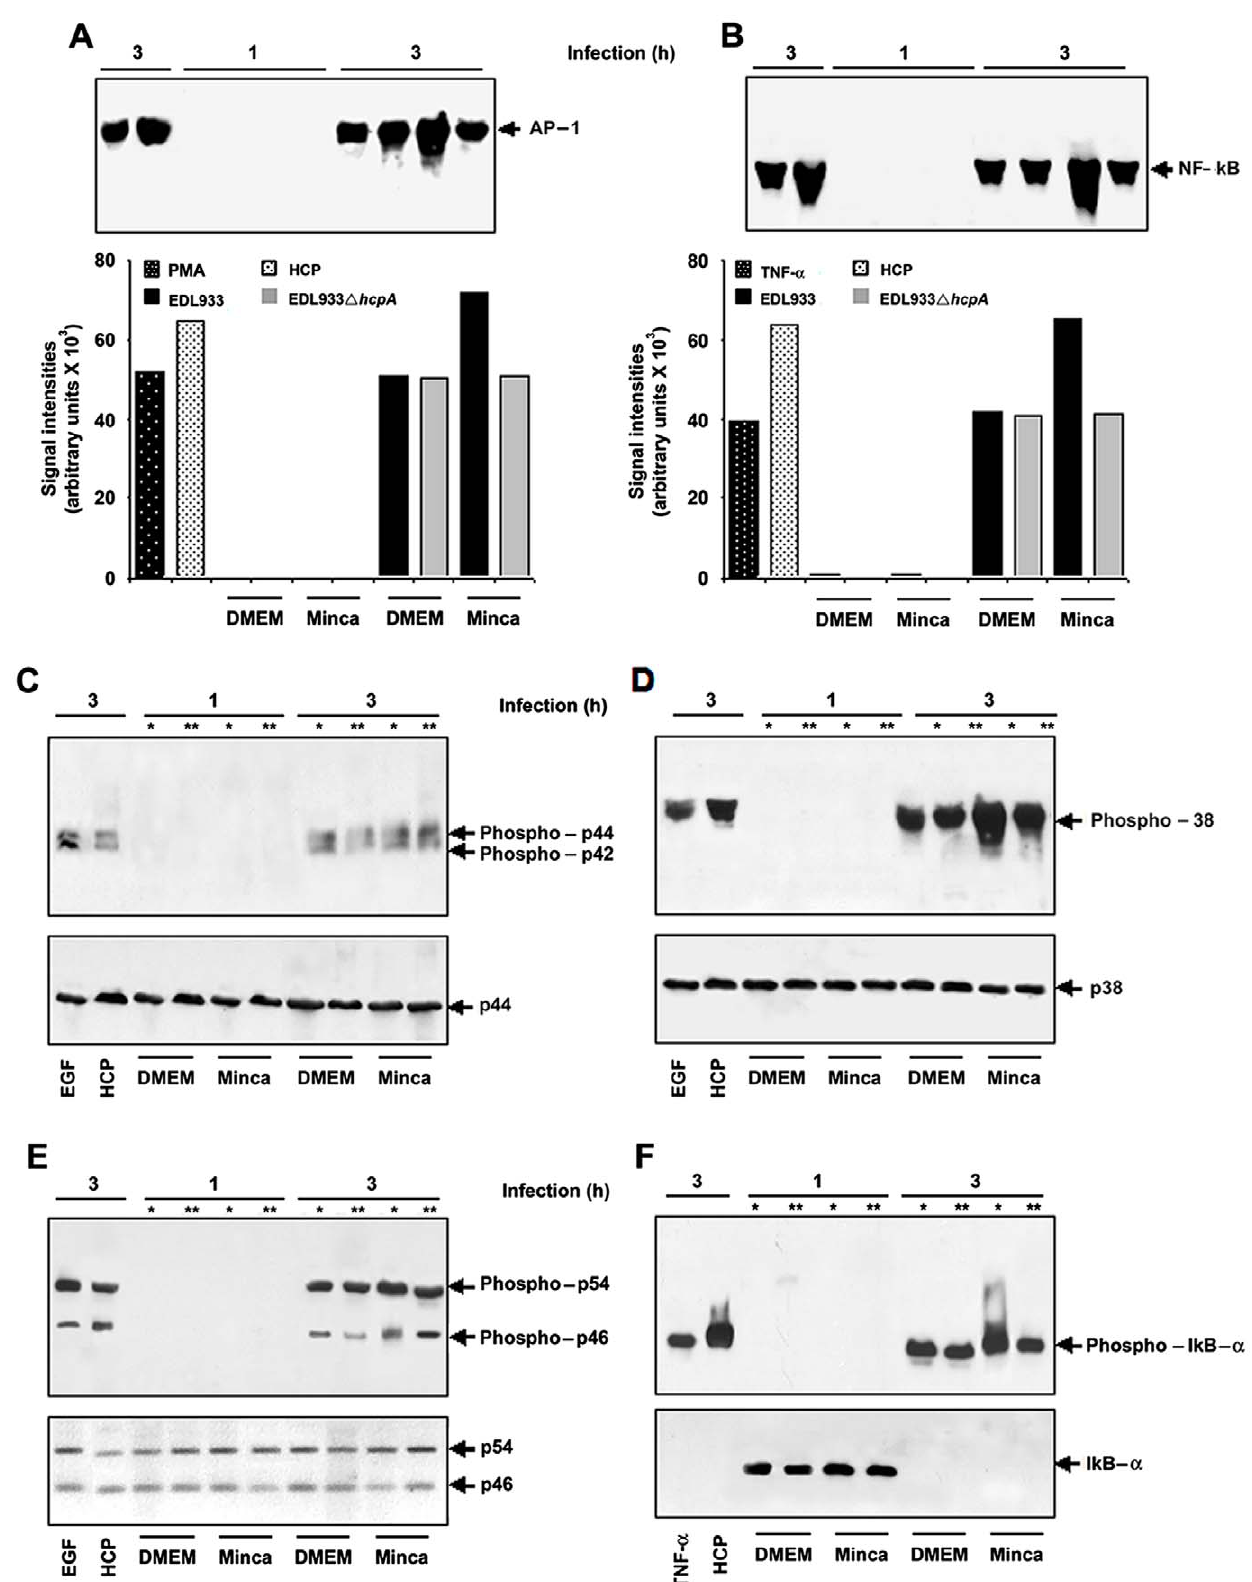
Figure 9. EHEC infection induced AP-1, NF- k B DNA binding, MAPK and I k B- a activation in HT-29 cells. Infection with purified HCP, wild- type O157:H7 and the hcpA mutant showing percentages of AP-1 activation; PMA: Phorbol myristate acetate (A). Infection with purified HCP, wild- type O157:H7 and the hcpA mutant showing percentages of NF- k B activation (B). Western blot showing the kinetics of MAPK activation using specific